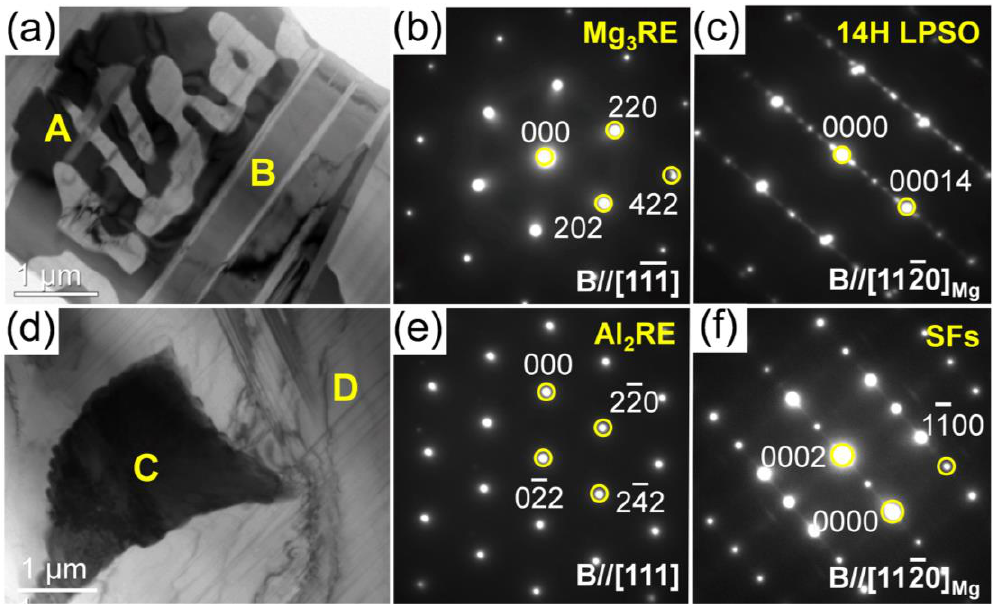
Figure 8. BF-TEM images along with the corresponding SAED patterns of the secondary phases in as-cast 0.5Zn-0.5Al alloy: ( a , d ) BF-TEM images; ( b , c , e , f ) the SAED patterns. Figure 9 shows the BF-TEM images, atomic-resolution high-angle annular dark field – scanning transmission electron microscopy (HAADF-STEM) micrographs and correspond- ing SAED patterns of the blocky phases (point E and G) and the plate-like phases (point F and H) in the as-cast 0.5Zn-1.0Al and 0Zn-1.0Al alloys. The results are summarized in Table 1. The results suggest that these phases were Mg 3 RE and 18R LPSO phases (an ordered base- centered monoclinic structure, a = 1.112 nm, b = 1.926 nm, c = 4.689 nm) [27], respectively. The width of the LPSO plate was over 1 μm. Moreover, the 18R LPSO phase was coherent with the Mg 3 RE phase, following a crystallographic OR as [00018] LPSO //[022] Mg3RE (Figure 9b,c). Meanwhile, the plate-like phase and the blocky phase observed in the as-cast 0Zn- 1.0Al alloy are identified as 18R LPSO and Mg 5 RE phases (face-centered cubic structure, a = 2.234 nm) [30], respectively. The width of the LPSO plate was approximately 300 nm. The 18R phase was also coherent with the Mg 5 RE phase, following a crystallographic OR as [00018] LPSO //[022] Mg5RE (Figure 9e,f). It should be noted that Zn addition has no effect on the orientation relationship. Figure 10a,c show the BF-TEM images of the typical polygonal phases in the as-cast 0.5Zn-1.0Al and 0Zn-1.0Al alloys. According to the corresponding SAED pattern, the polygonal phase with large size was identified as Al 2 RE (Figure 10b). Moreover, the Al 2 RE phase was coherent with the matrix, following a crystallographic OR as [10 1 ̅ 0] α -Mg //[110] Al2RE , (0002) α -Mg //(111) Al2RE (Figure 10d).